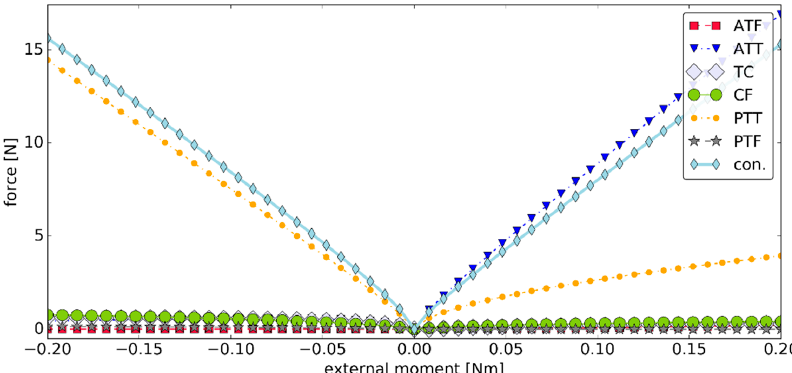
Figure 6. The values of the forces generated by the ligaments versus the external moment M ext in simulation #1, where "con." is the magnitude of the contact force generated by the two contact